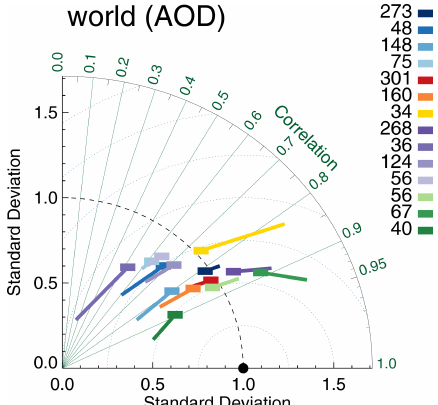
Figure 4. Taylor diagram for satellite products evaluated over either land or ocean with MAN. Symbols indicate correlation and inter- nal variability relative to MAN; the line extending from the symbol indicates the (normalized) bias (see also Sect. 3.1). Colours indi- cate the satellite product (see also Fig. 1); numbers next to coloured blocks indicate the amount of collocated data. Products were indi- vidually collocated with AERONET (Kinne et al., 2013, selection, pruned) within